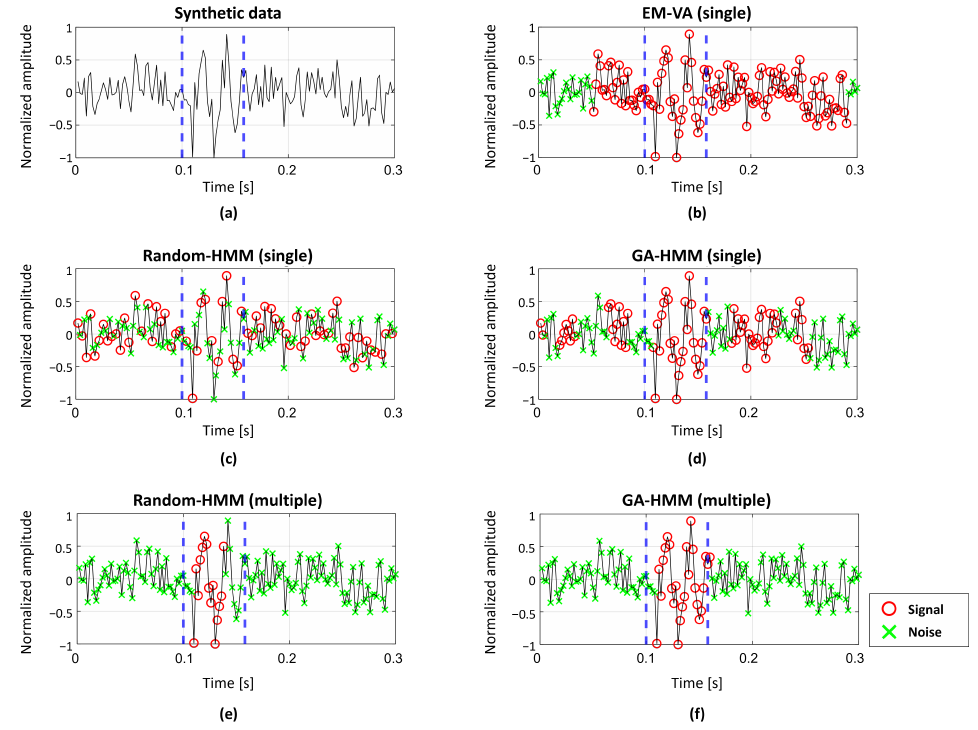
Figure 4. ( a ) Representative example of synthetic data with SNR of 8 dB. Detection results from ( b ) EM-VA, ( c ) single-measurement Random-HMM, ( d ) single-measurement GA-HMM, ( e ) multiple- measurement Random-HMM, and ( f ) multiple-measurement GA-HMM. The Interval for SOI is indicated by vertical dashed lines. Symbols “o” and “x” represent “signal” and “noise” states,